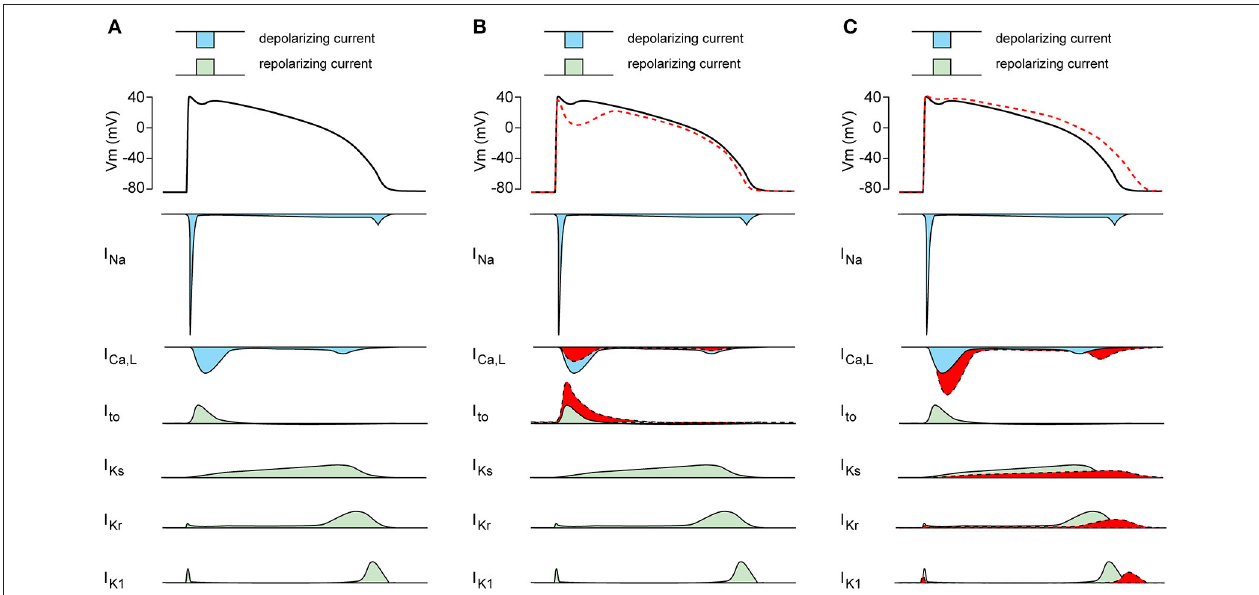
FIGURE 2 | (A) Schematic drawing of the cardiac action potential (AP) and its underlying membrane currents. I Na , Na + current; I Ca,L , L-type Ca 2 + current; I to , transient outward K + current; I Ks , slow component of the delayed rectifier K + current; I Kr , rapid component of the delayed rectifier K + current; I K1 , inward rectifier K + current. (B) Schematic drawing of AP plateau suppressing ion channels changes (in red). (C) Schematic drawing of AP prolonging ion channels changes (in red).